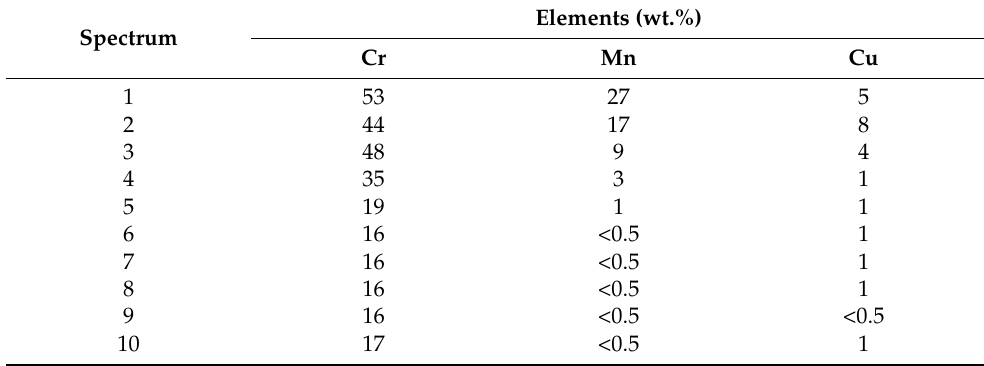
Table 7. Results of EDS analysis performed at spots of Figure